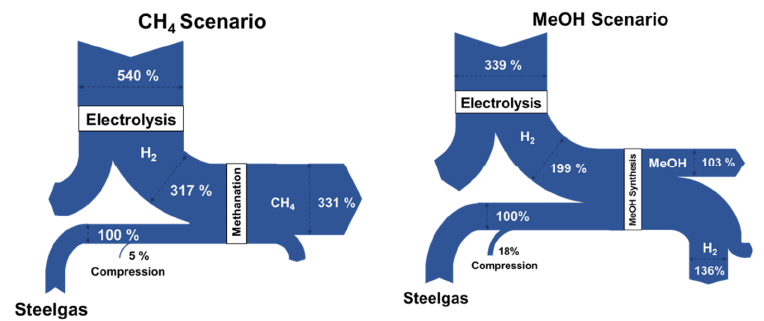
Figure 13. PEM and SOEC electrolysis requirements (MeOH: S.N. = 1.7, CH 4 : Stoichiometric).